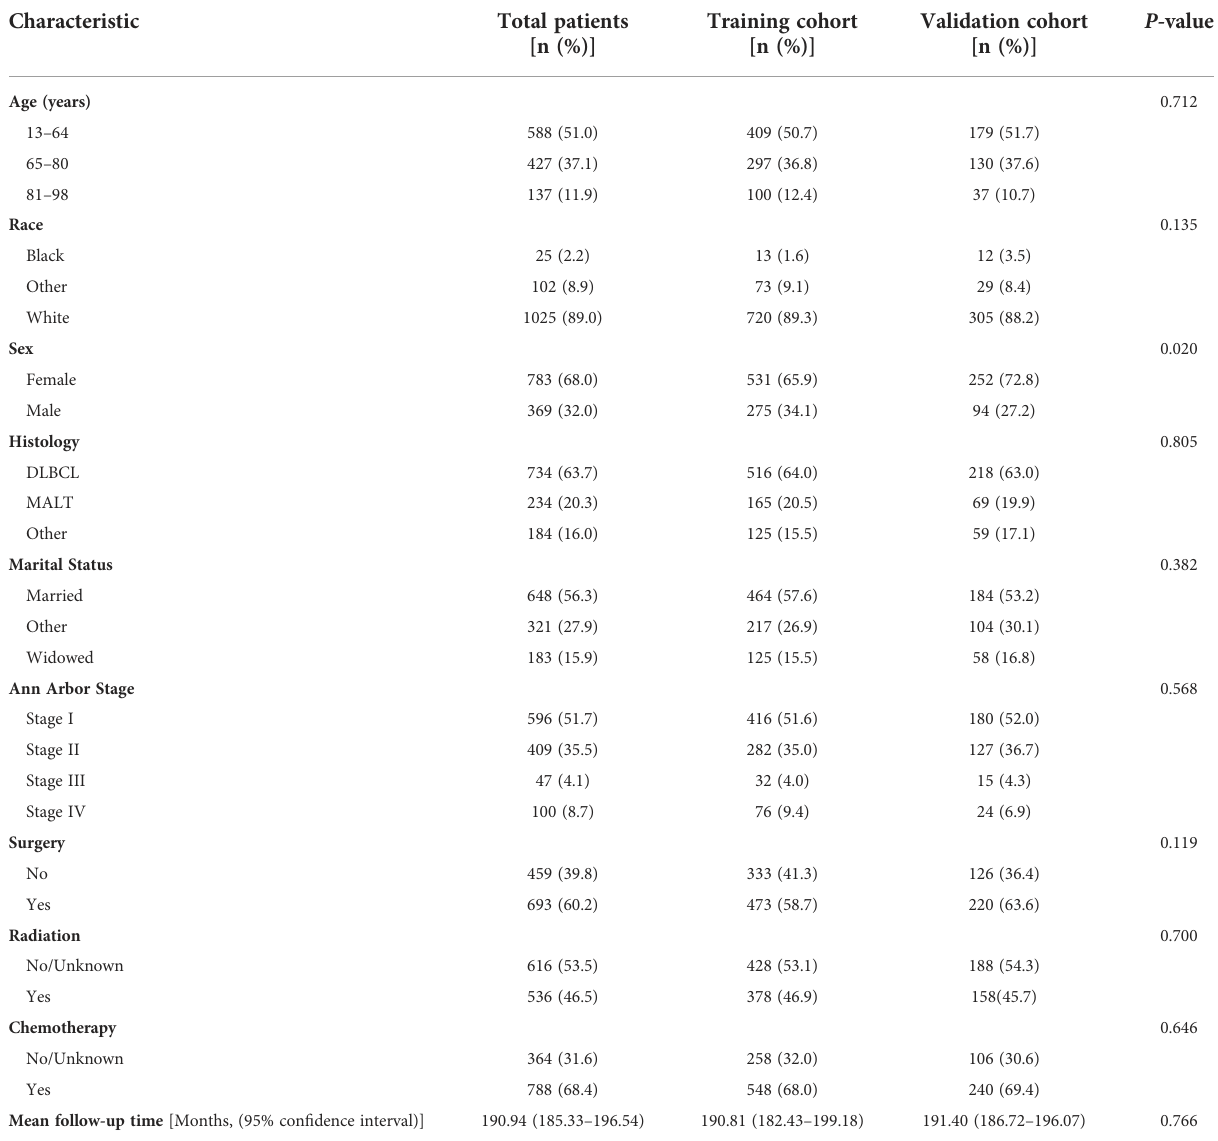
TABLE 1 Characteristics of BC-PTML patients included in the study and analysis of differences.